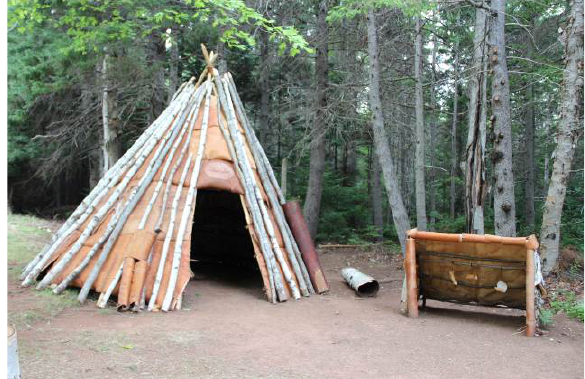
Figure 5. Traditional Mi’kmaq construction in Skmaqn–Port-la-